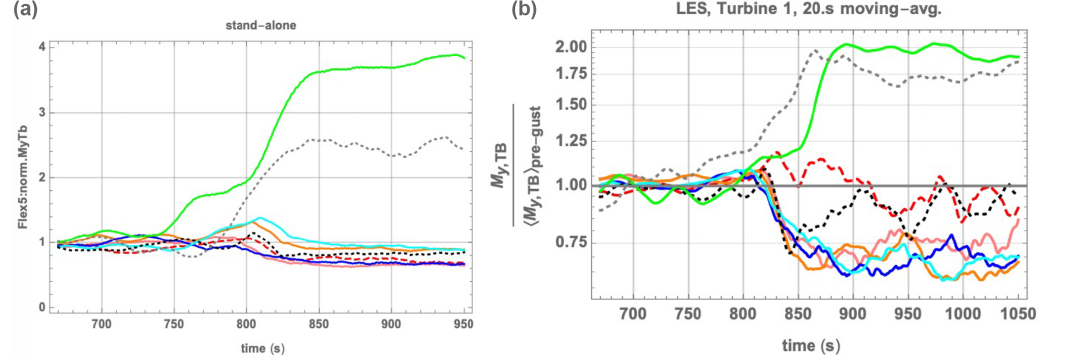
Figure 15. Tower-base fore–aft moment M tbfa , normalized by pre-ramp mean values, for all eight ramp cases (colors same as in Fig. 11). (a) Stand-alone Mann-model/Flex5 simulation; (b) coupled LES, first (upwind) turbine.